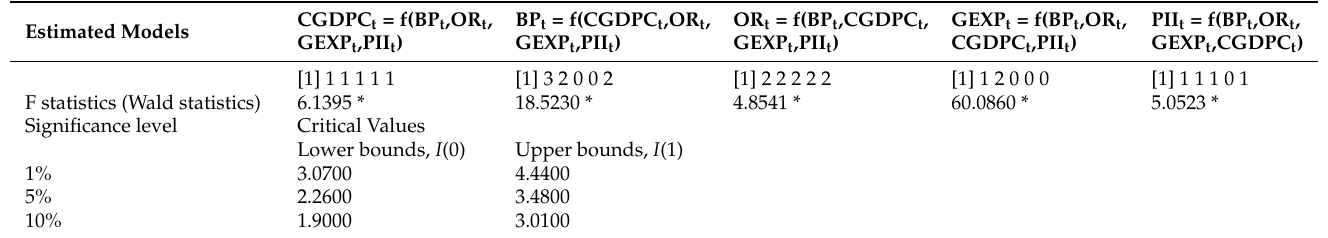
Table 4. Bounds F-test (Wald) for no cointegration with nor intercept or trend. Estimated Models